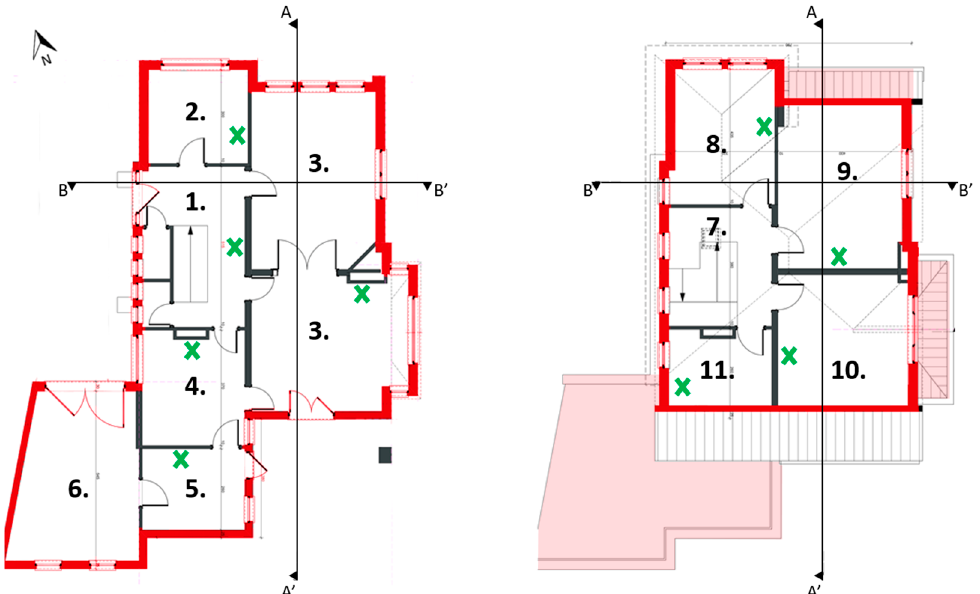
Figure 2. Floor plans of the case study building, with (1) entrance hall with cloakroom and toilet, (2) study, (3) living room, (4) kitchen, (5) utility room, (6) former garage used as storage space, (7) landing, (8)–(10) bedrooms, and (11) bathroom. The X marks indicate the locations of the interior temperature sensors (see Section 2.2). The building fabric of which the heat loss coefficient (HLC) will be assessed, is colored red.